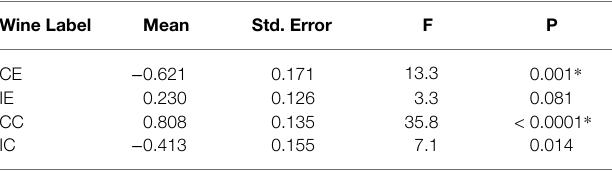
TABLE 5 | Mean of the PCN amplitudes for each bottle/label averaged across sessions from 200 to 240 ms, standard errors of the mean, and results of F tests as deviation from “0.”